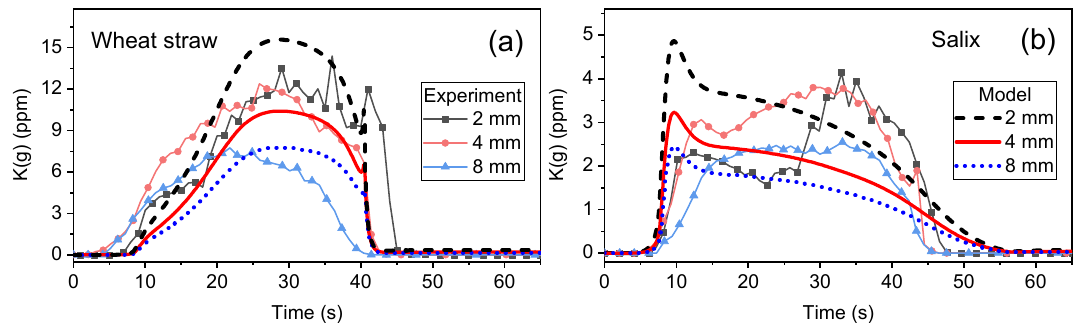
Figure 5. Comparison between TDLAS-measured and simulated atomic K concentrations at different laser beam heights (2, 4 and 8 mm) above wheat straw ( a ) and Salix ( b ) particles. Lines with markers represent the measured data; lines show the model prediction.